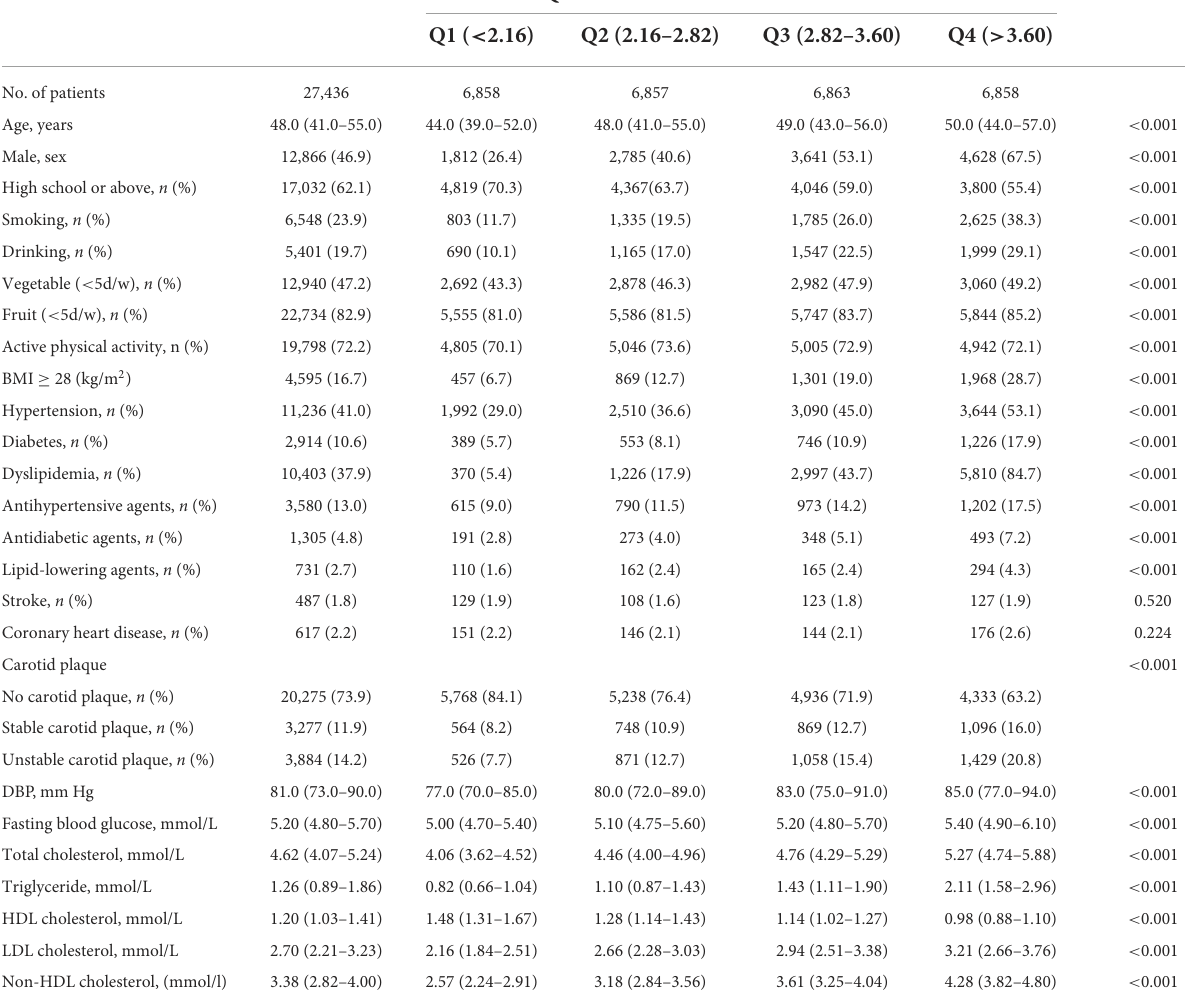
TABLE 1 Baseline characteristics of the study participants.